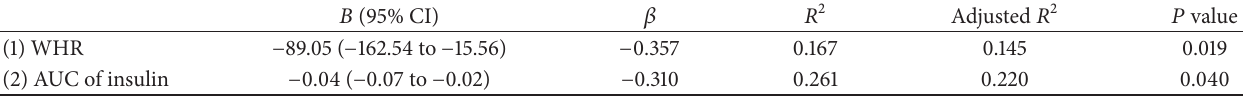
Table 3: The variable independently related to altered daytime fluctuation pattern of PAI-1 in multiple stepwise linear regression analyses. 𝐵 (95% CI) 𝛽 𝑅 2